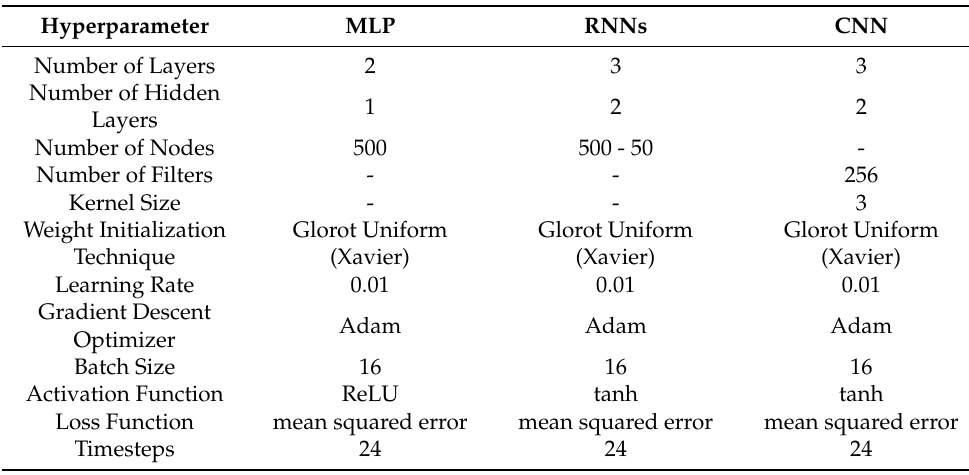
Table 8. The selected hyperparameters of the deep learning